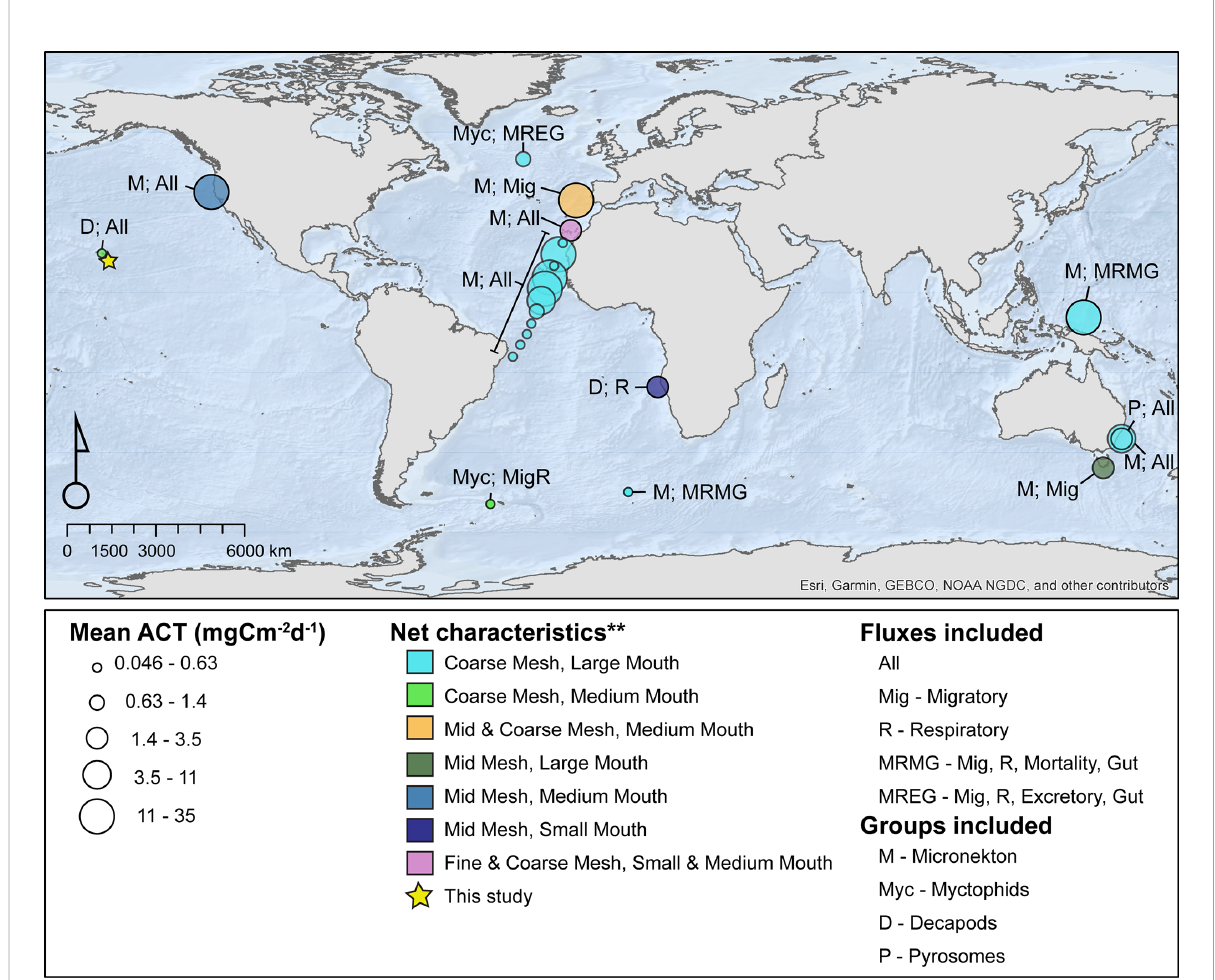
FIGURE 1 Summary of past micronekton active carbon transport (ACT) studies globally (N = 12) where the size of symbol indicates total fl ux, color indicates net characteristics (i.e., the mesh and mouth size of the sampling gear), and fl uxes and groups included are indicated with letters. Nets with two mesh and/or two mouth sizes indicate that two different sampling gears were used. Williams and Koslow, 1997; Angel and Pugh, 2000; Hidaka et al., 2001; Davison et al., 2013; Schukat et al., 2013; Hudson et al., 2014; Ariza et al., 2015; Pakhomov et al., 2018; Belcher et al., 2019; Henschke et al., 2019; Herna ́ ndez-Leo ́ n et al., 2019 (the study includes multiple stations), Kwong et al., 2020; Cotte ́ et al.,